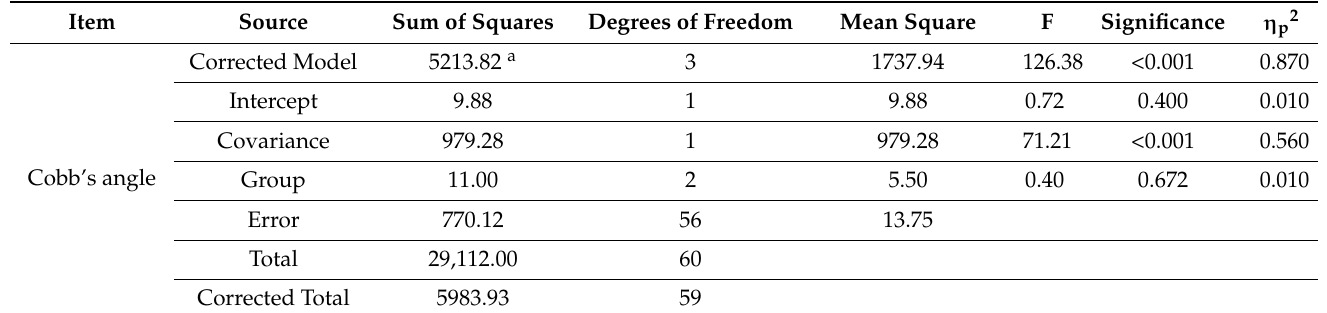
Table 4. Analysis of covariance results for Cobb’s